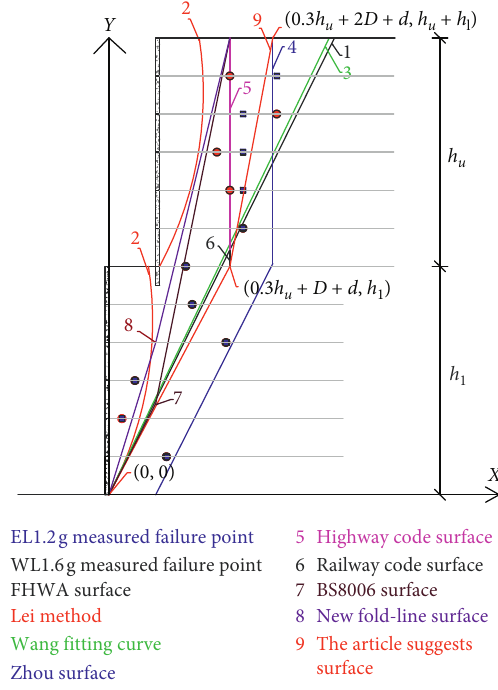
Figure 20: Potential failure surface calculation method of specimen 2.